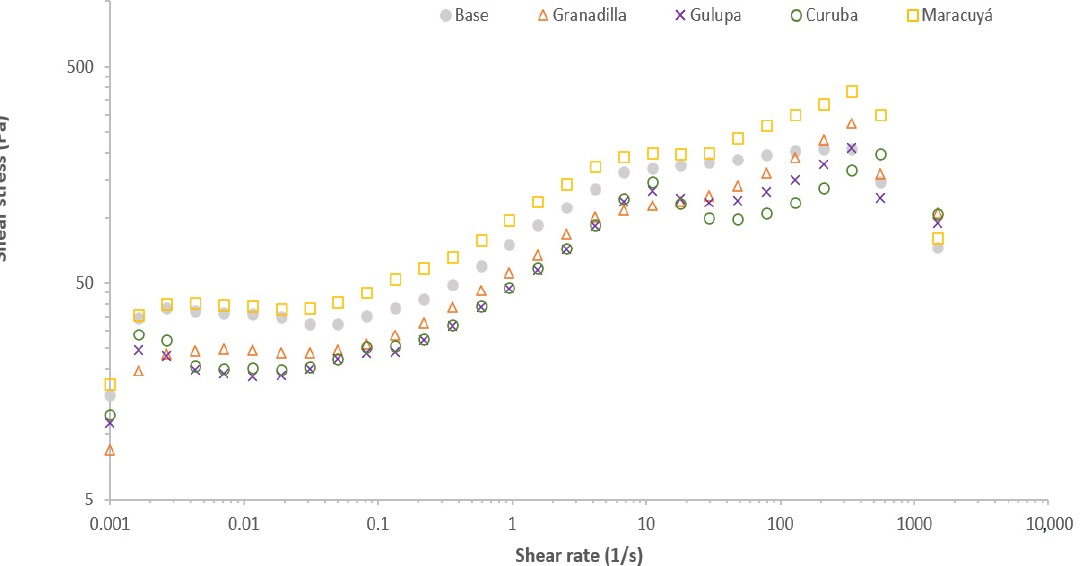
Figure 5. Shear stress profiles of exfoliant prototypes. “Granadilla” ( Passiflora ligularis ), “gulupa” ( P. edulis Sims fo edulis ), “curuba” ( P. mollissima ), and “maracuyá” ( P. edulis , reference).